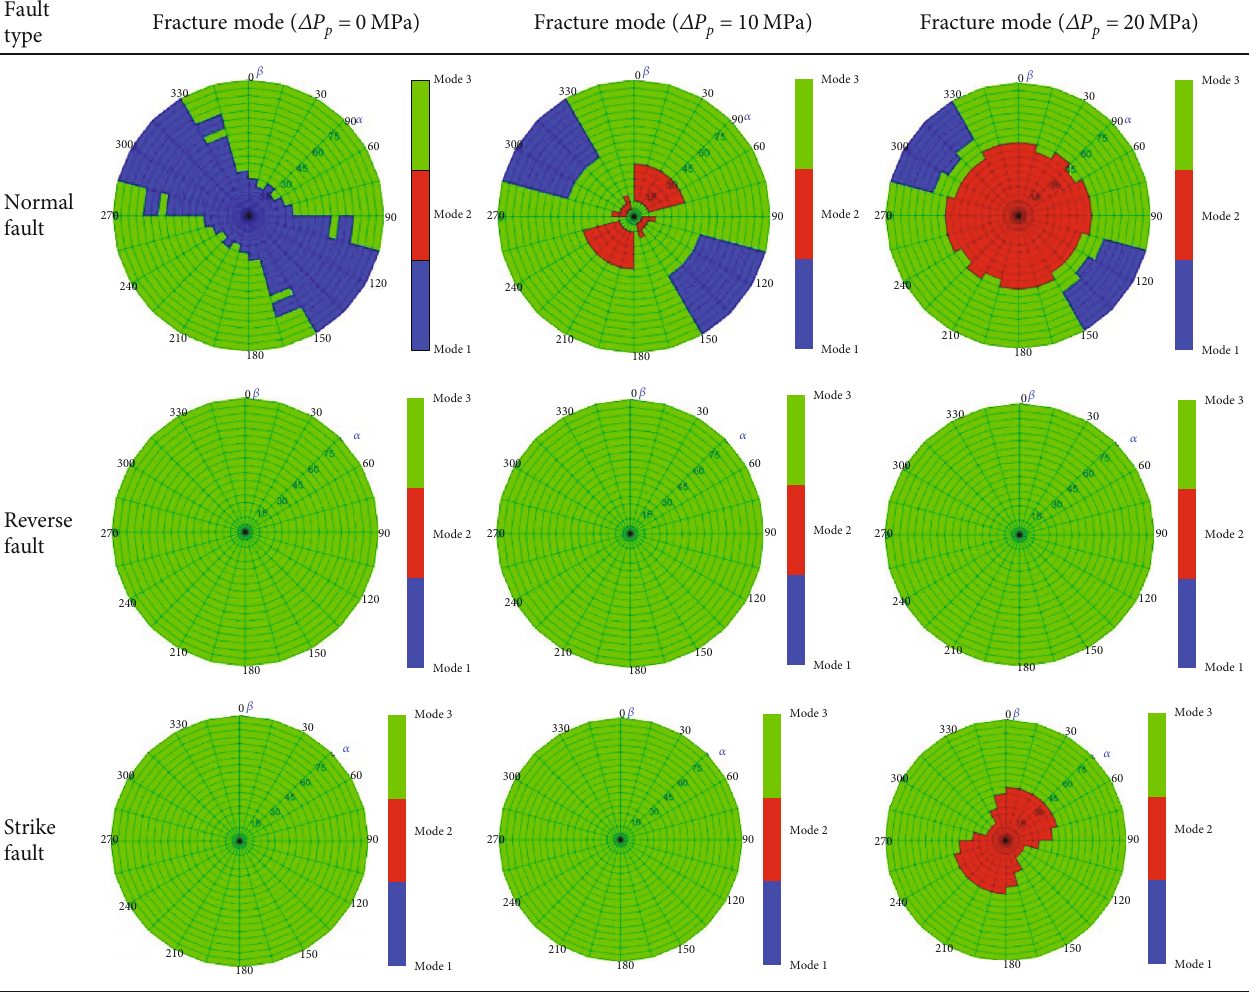
Table 1: Change of fracture mode with reservoir depletion of directional wellbore drilled in di ff erent fault stress regimes.